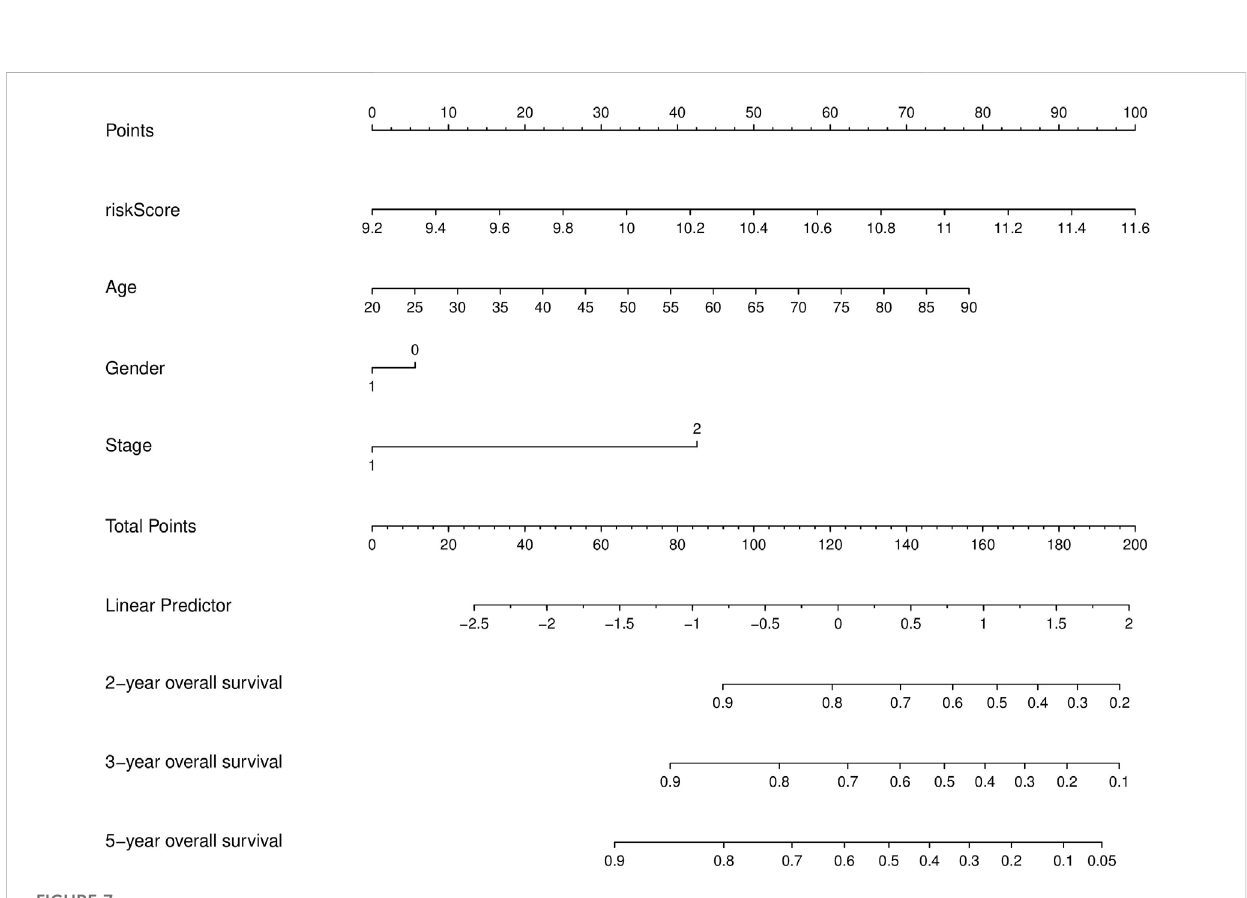
FIGURE 7 Nomogram for the prediction of 1-, 3-, and 5-year survival probability in patients GC.